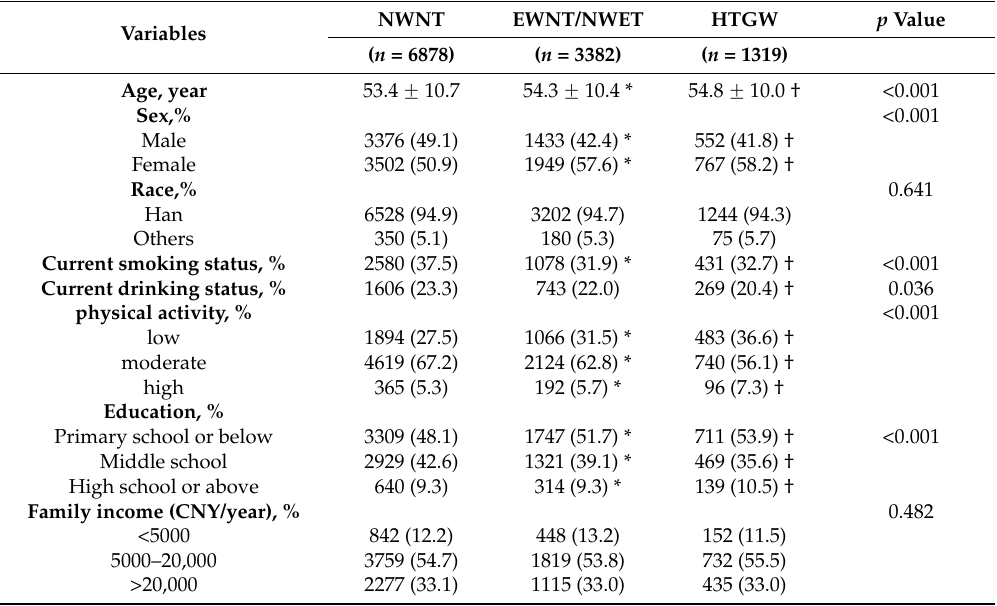
Table 1. Baseline characteristics of the participants in each phenotype group ( n = 11,579).